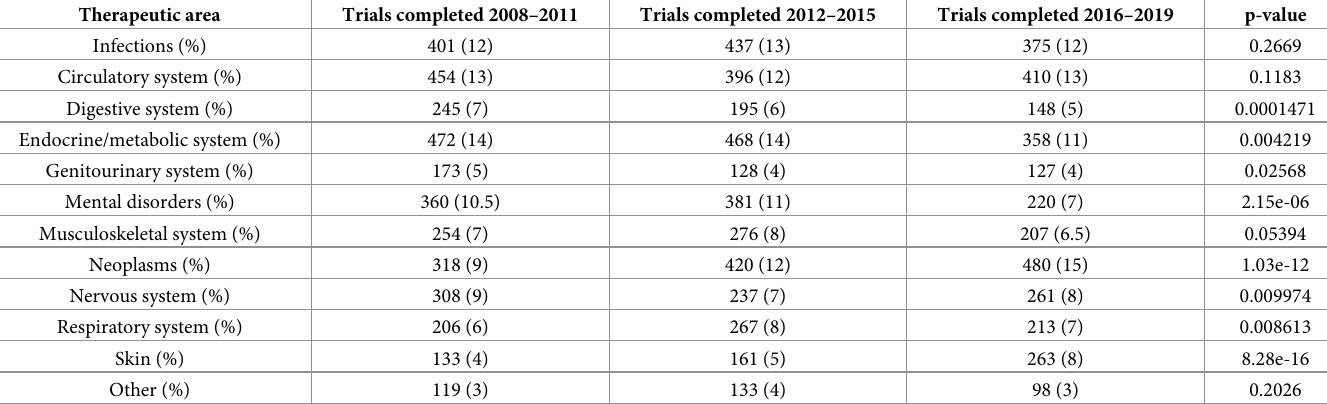
Table 4. Development of therapeutic area investigated in clinical trials completed from